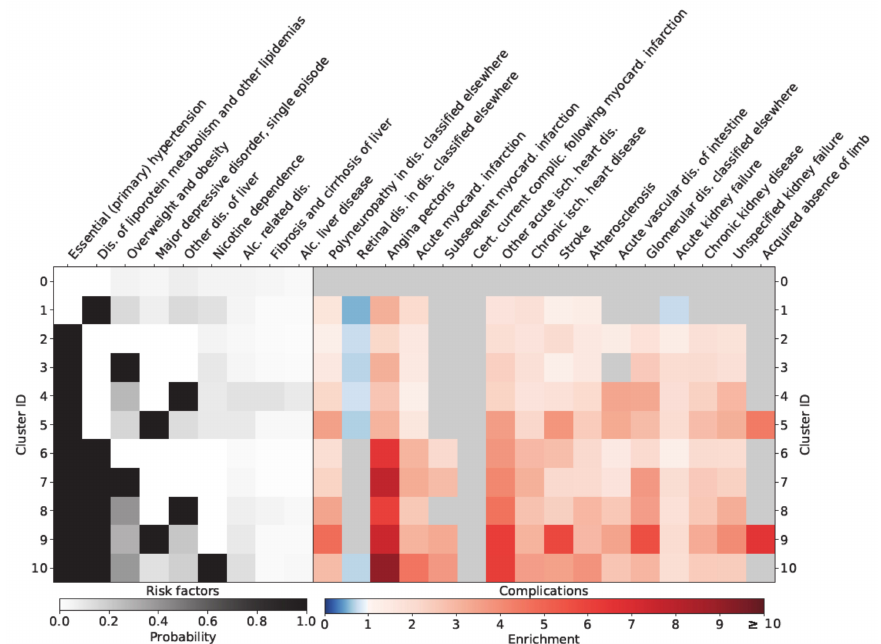
Figure 3. Relationship of different clusters with typical diabetes-specific complications in